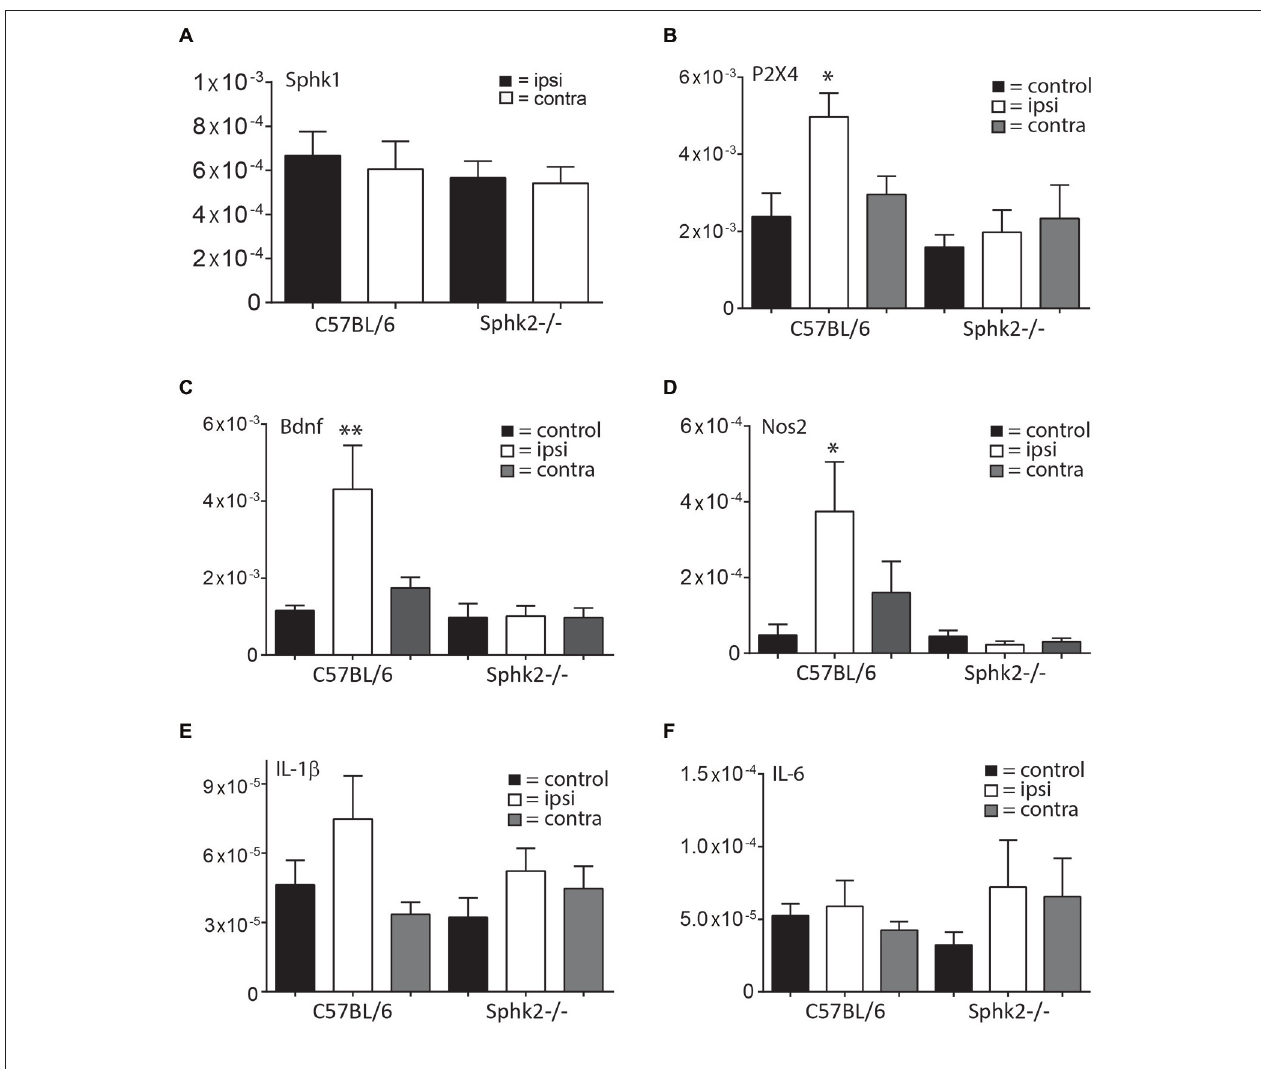
control mice (control) and in ipsi- (ipsi) and contralateral (contra) lumbosacral SC of C57BL/6 and Sphk2 − / − mice after 7 days CFA. (D) Relative mRNA-expression levels for the Nos2 (iNos) in lumbosacral SC of untreated control mice (control) and in ipsi- (ipsi) and contralateral (contra) lumbosacral SC of C57BL/6 and Sphk2 − / − mice after 7 days CFA. (E,F) Relative mRNA-expression levels for the Il-1 β and Il-6 in lumbosacral SC of untreated control mice (control) and in ipsi- (ipsi) and contralateral (contra) lumbosacral SC of C57BL/6 and Sphk2 − / − mice after 7 days CFA. Values represent mean ± SEM, n = 5–8, one-way ANOVA, Bonferroni post hoc test, ∗ p < 0.05, ∗∗ p <